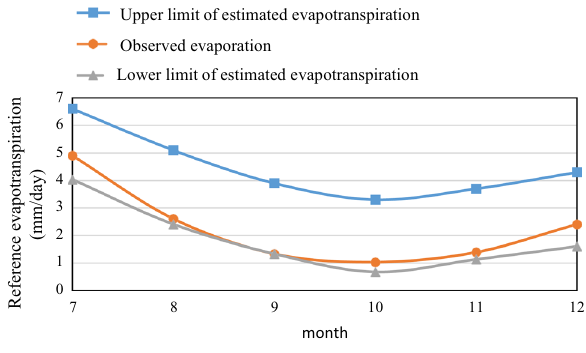
Fig. 4 Observed and predicted evapotranspiration charts (Hargreaves